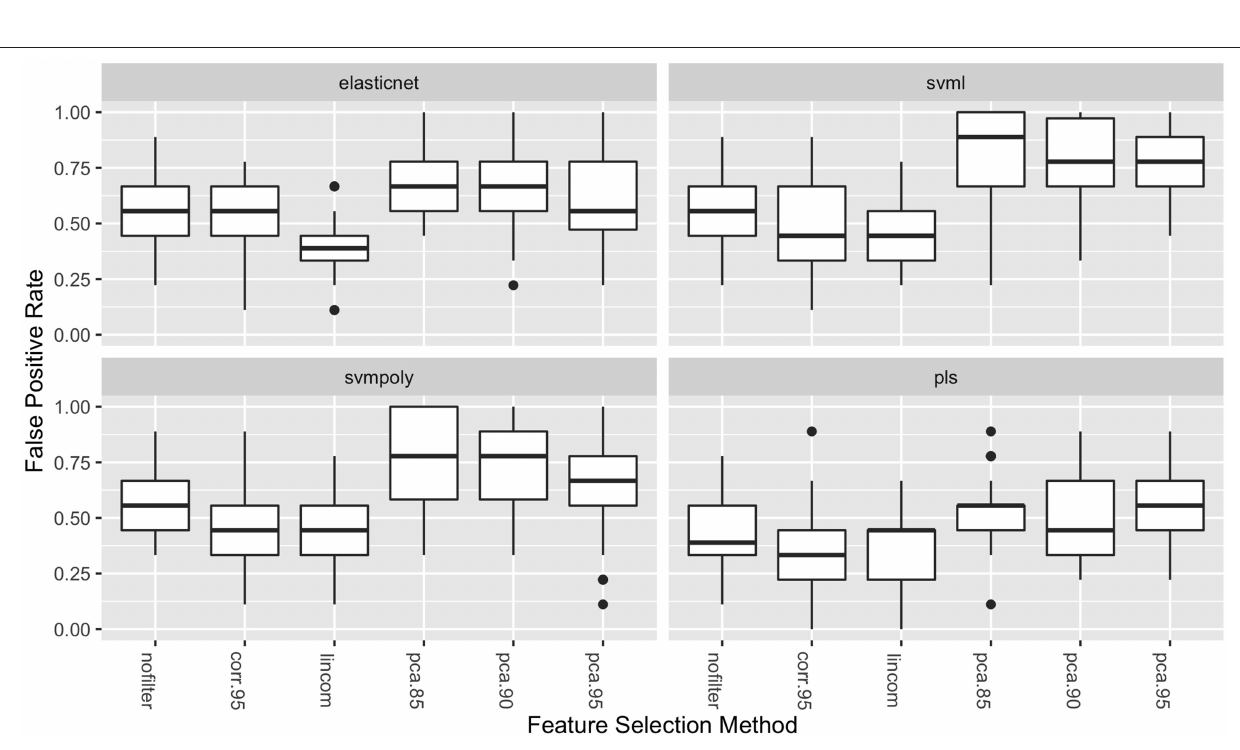
Frontiers in Oncology |